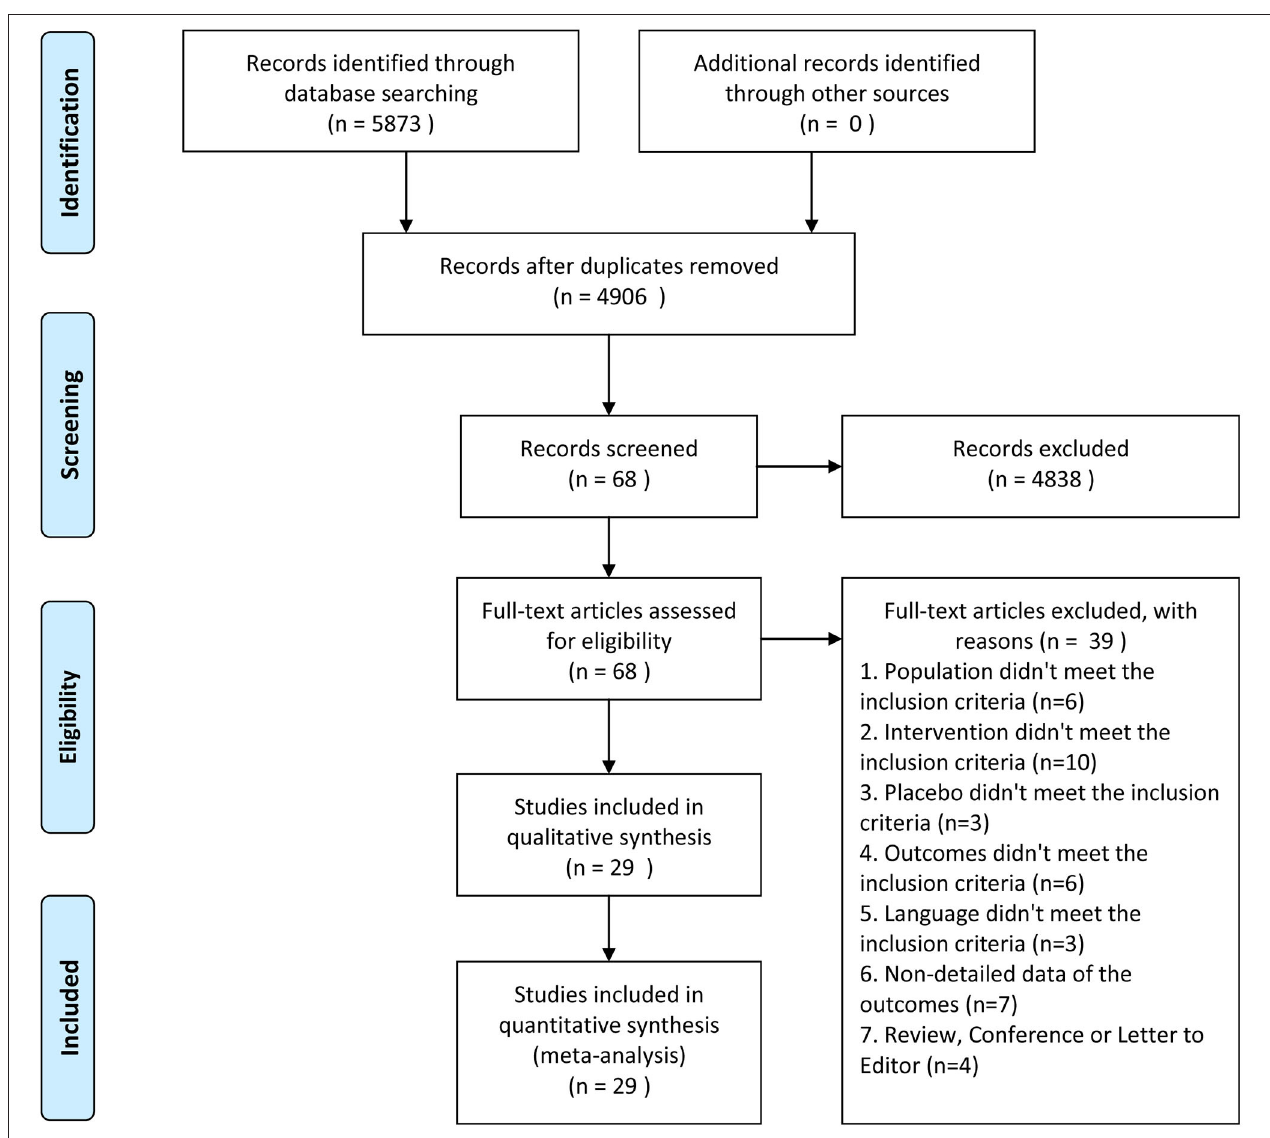
FIGURE 1 | Flow diagram of selection